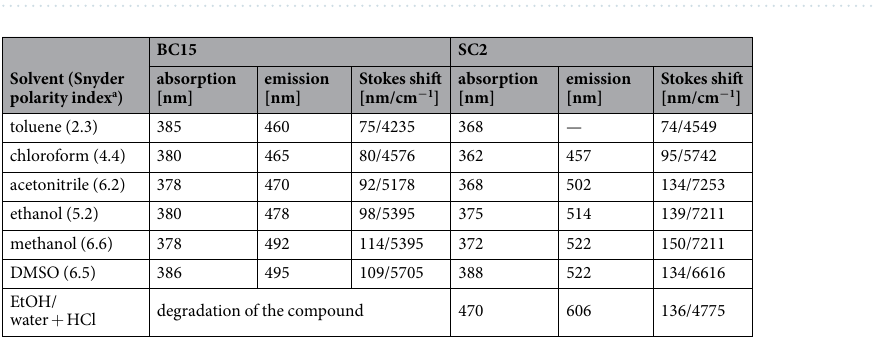
Figure 1. The synthetic pathway of compound BC15 . Reagents and conditions: ( a ) 4-nitrobenzaldehyde/Ac 2 O, ( b ) SnCl 2 /EtOH, ( c ) 6-amino-1,3-dimethyl-2,4-dioxo-1,2-3-4-tetrahydropyrimidine-5-carbaldehyde /EtOH, microwave conditions 50 W, 80 °C, 20 min.